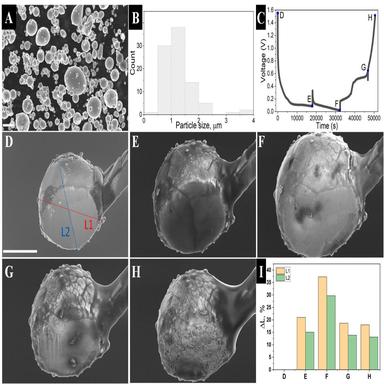
(A) SEM images and the corresponding size histogram of microsized Sn powder. (C-H) The initial charge/discharge curve and the corresponding SEM images of single Sn particle during in situ SEM experiment. (I) Variation percentage of length in L1 and L2 direction (D) at different charge/discharge states. The scale bars in Fig. 1 are 5 µm.